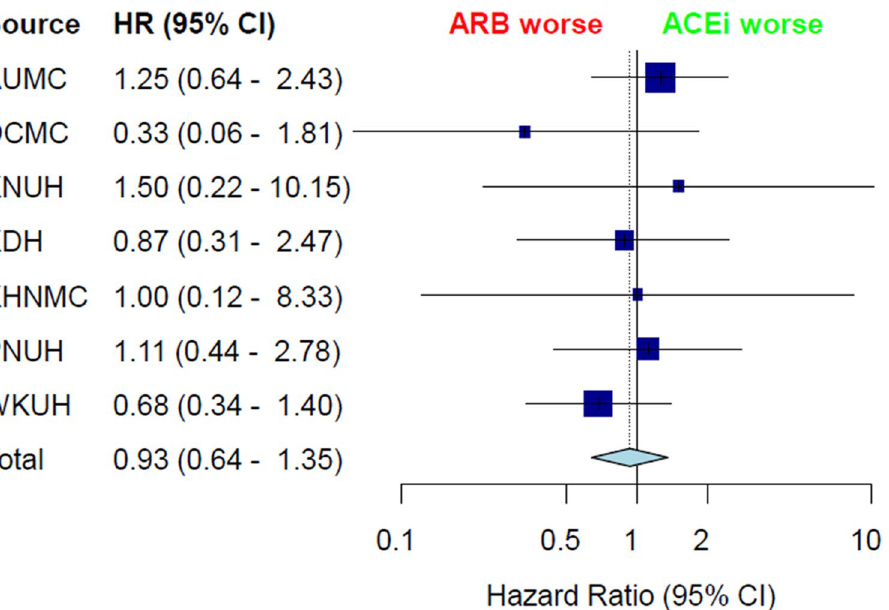
Figure 3. Incidence of lung cancer in the propensity-score matched population. AUMC Ajou University Medical Center, DCMC Daegu Catholic University Medical Center, KNUH Kangwon National University error of individual studies, HR hazard ratio, CI confidence interval, ACEi angiotensin-converting enzyme inhibitor, ARB angiotensin receptor